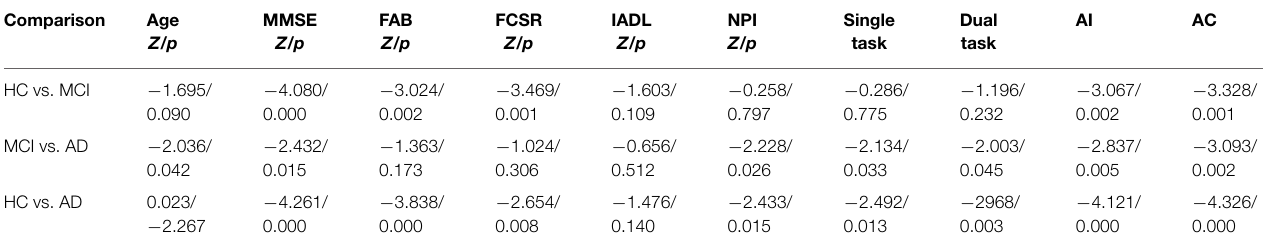
TABLE 3 | Intergroup comparison of scores and performance results from the ecological assessment (Mann–Whitney U test) . Comparison